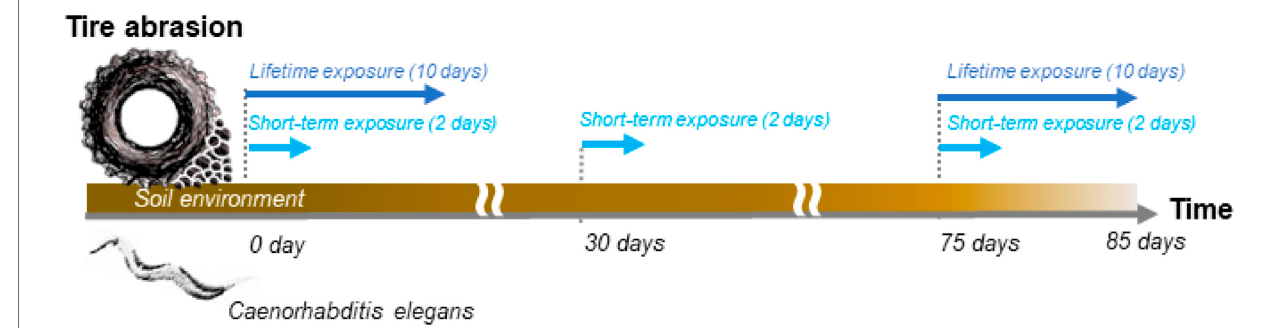
FIGURE 1 | The diagram of soil toxicity tests in this study. The TWP toxicity tests were conducted using nematode Caenorhabditis elegans with two different exposure times (2 and 10 days) and three different pre-incubation times (no pre-incubation, 30 days, and 75 days).